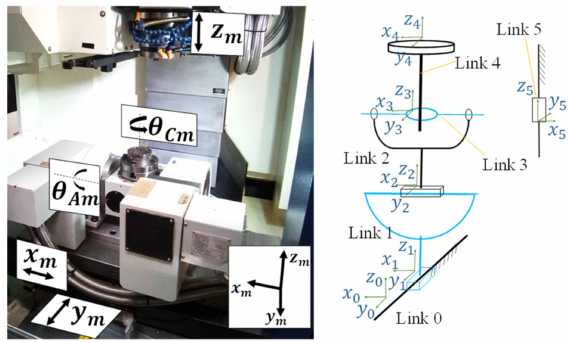
Figure 2. Schematic diagram of the